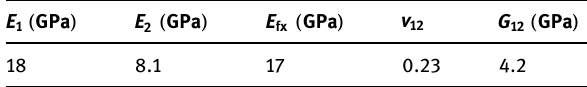
Table 3: Mechanical properties of E - glass/vinyl ester laminate